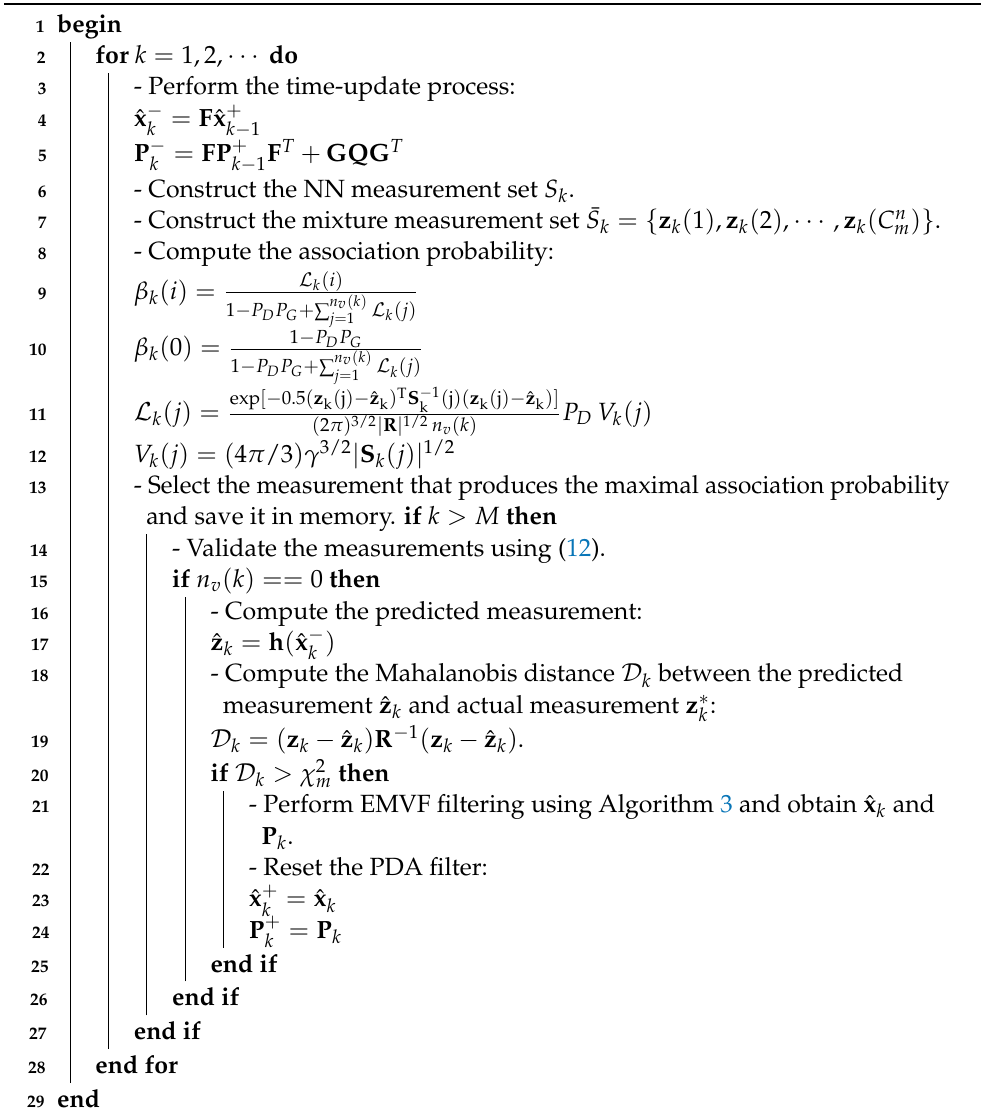
Algorithm 4: Localization based on